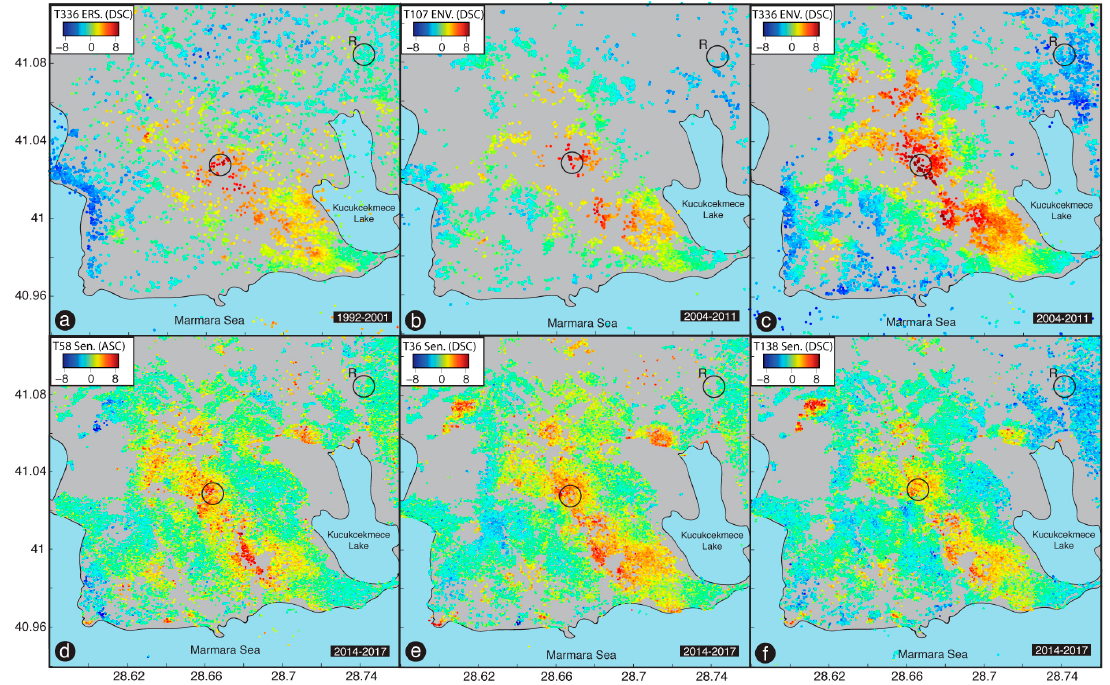
Figure 6. Zoom views of displacement rates in the Haramidere Valley and its surrounding area. The mean velocity value of the persistent scatterers (PS)-InSAR points within the solid black circle in the center of the maps has been used to illustrate the temporal evolution of the subsidence associated with weak lithology (Figure 8). It is referenced to the mean value of the PS-InSAR points within the circle labeled R, which is considered a stable area. The DSC and ASC labels are for the descending and ascending orbits, respectively.